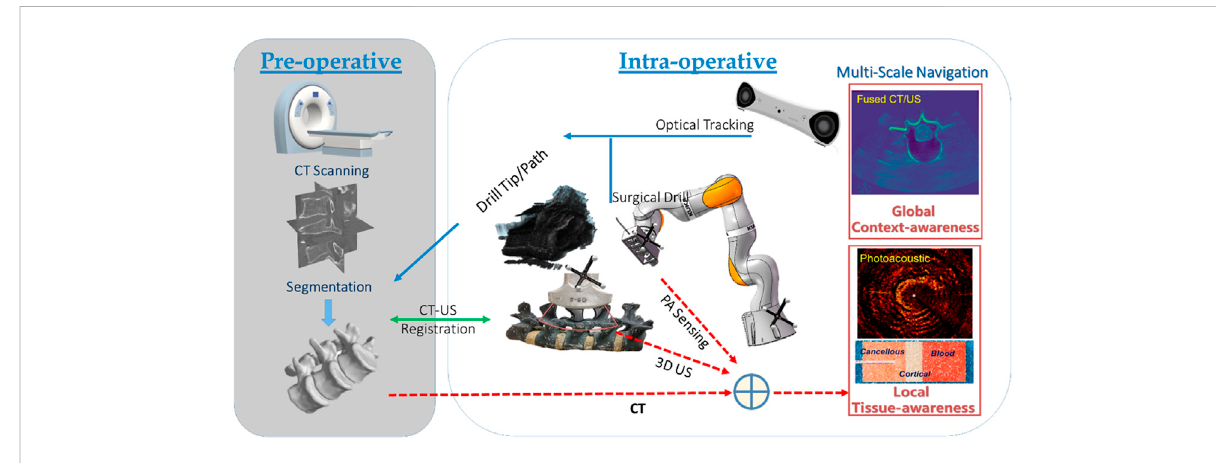
FIGURE 1 Multi-scale surgical navigation and sensing paradigm based on radiation-free intra-operative US/PA